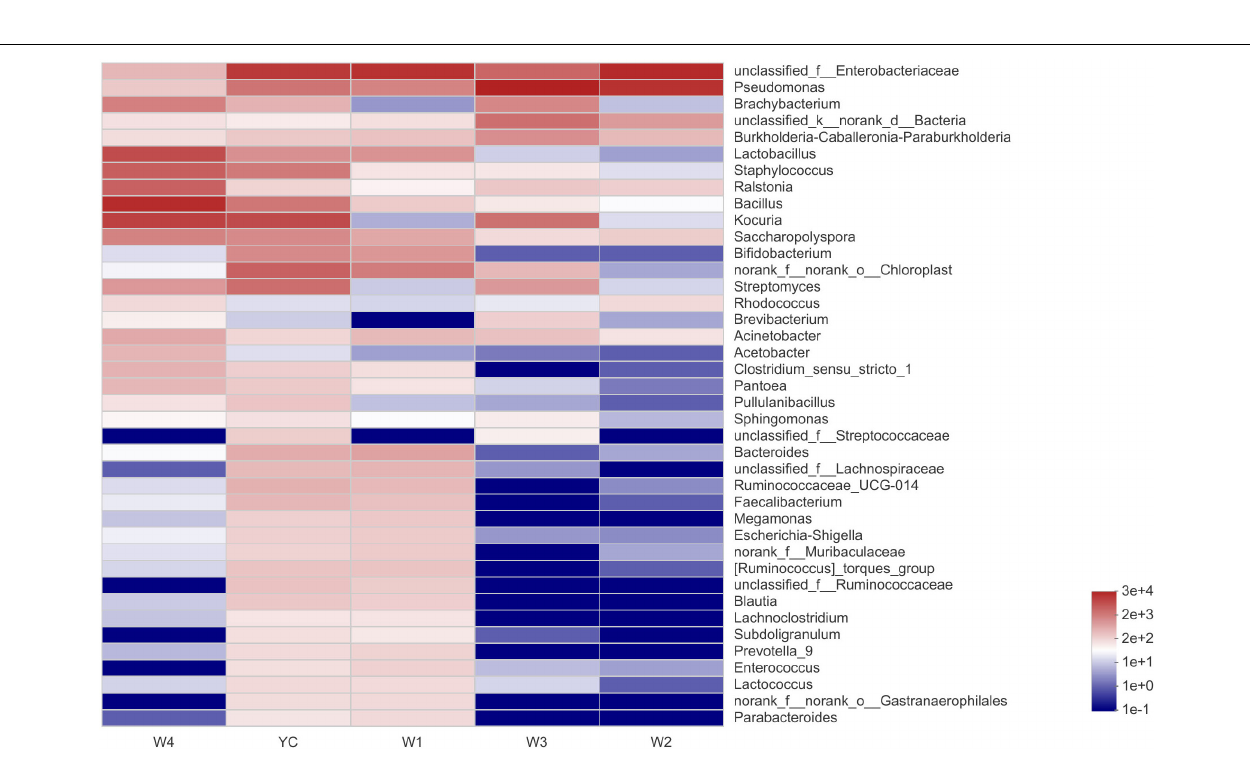
FIGURE 4 | Community heat map analysis at the genus level. The abscissa represents the group name, and the ordinate represents the taxa name. Abundance changes of different taxa in each sample are displayed by color gradient of the color block. The bar on the right side of the figure represents the abundance value by color